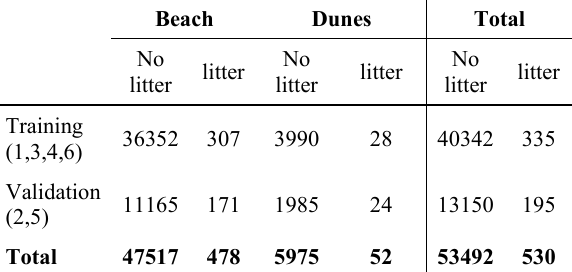
Table 1 Total number of image samples for the training and